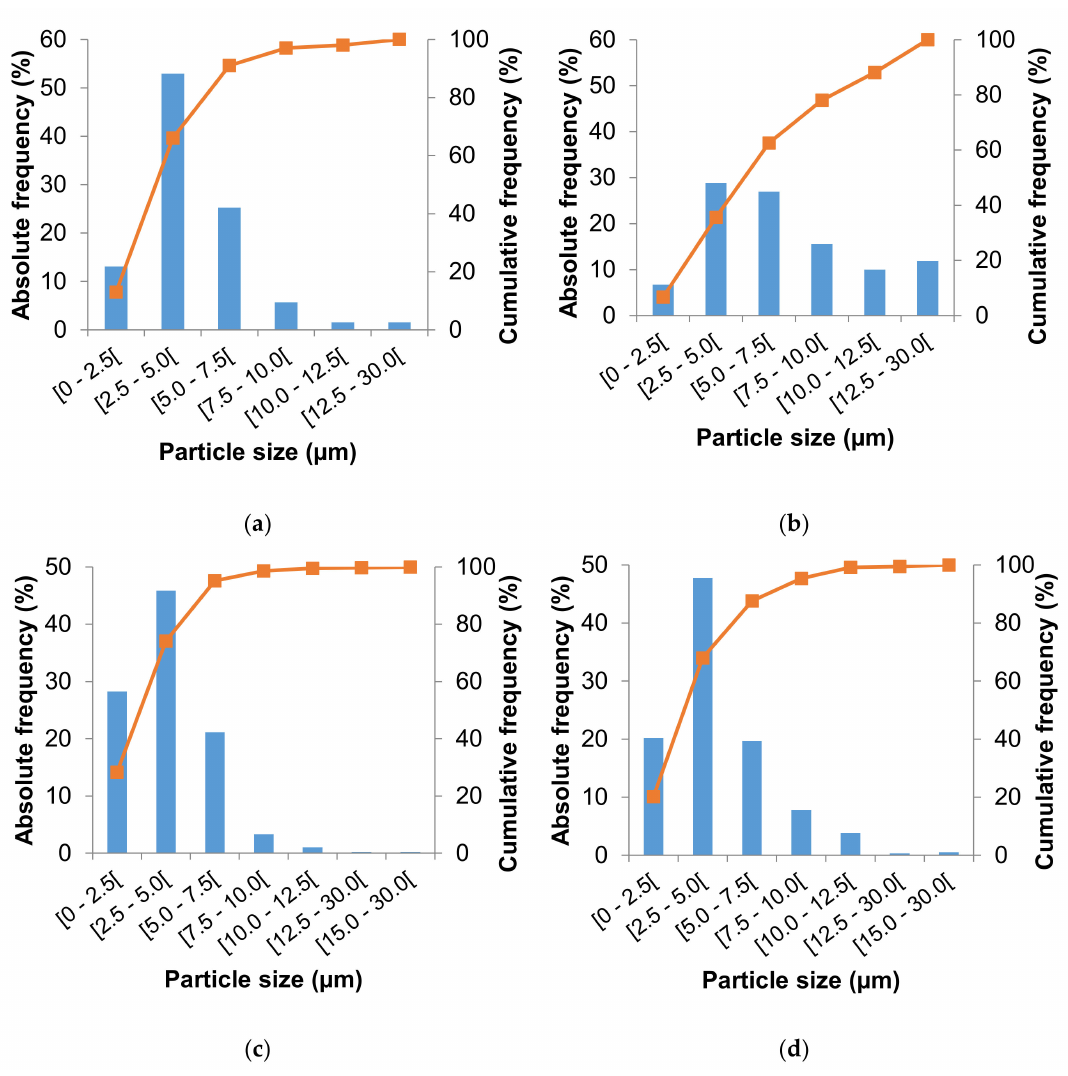
Figure 1. Relative frequency (Bars) and cumulative frequency (Line) equivalent to the diameter of microcapsules: ( a ) 5% AG, 155 ◦ C; ( b ) 35% AG, 155 ◦ C; ( c ) 5% inulin, 155 ◦ C; ( d ) 35% inulin, 155 ◦